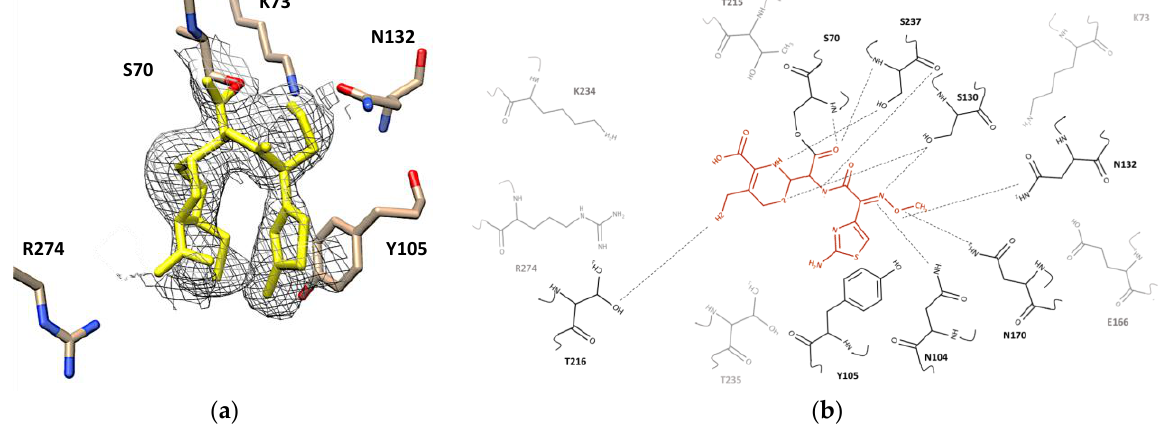
Figure 5. Active site of CTX-M-15 in DFC-enzyme complex. ( a ) Electron density map of the CTX-M-15 active site bound to DFC in the yellow color. The 2Fo-Fc map (contoured at 1.0 sigma) is shown in gray. Residues around the binding pocket of the DFC-CTX-M-15 crystal structure are depicted as cream, red, blue sticks. The UCSF Chimera v1.13.1. (SF, CA, USA). built this figure. ( b ) The 2D structure of DFC (red color) in the binding pocket of CTX-M-15. All residues have been showed, the hydrogen bond drown by dashed lines. The residues had interaction with DFC were in dark black color, and other ones did not have interaction in the gray color. The figure was generated with the MarvinSketch v.17.28.0. (Budapest, Hungary).